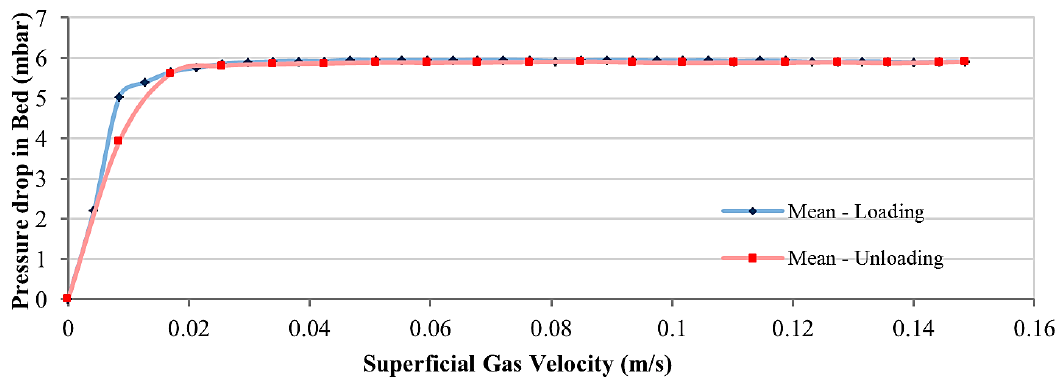
Figure 14. Mean value of ∆ P b ( U sg ) when repeating fluidization tests for fluidization loading and